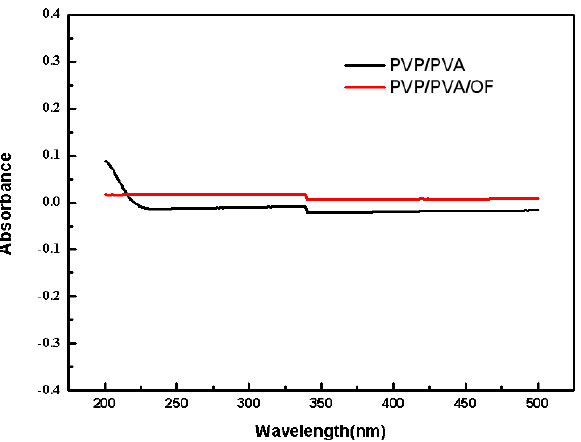
Figure 4. The stability of PVP/PVA hydrogel and OF/PVP/PVA hydrogels with a concentration of 100 μg/mL.